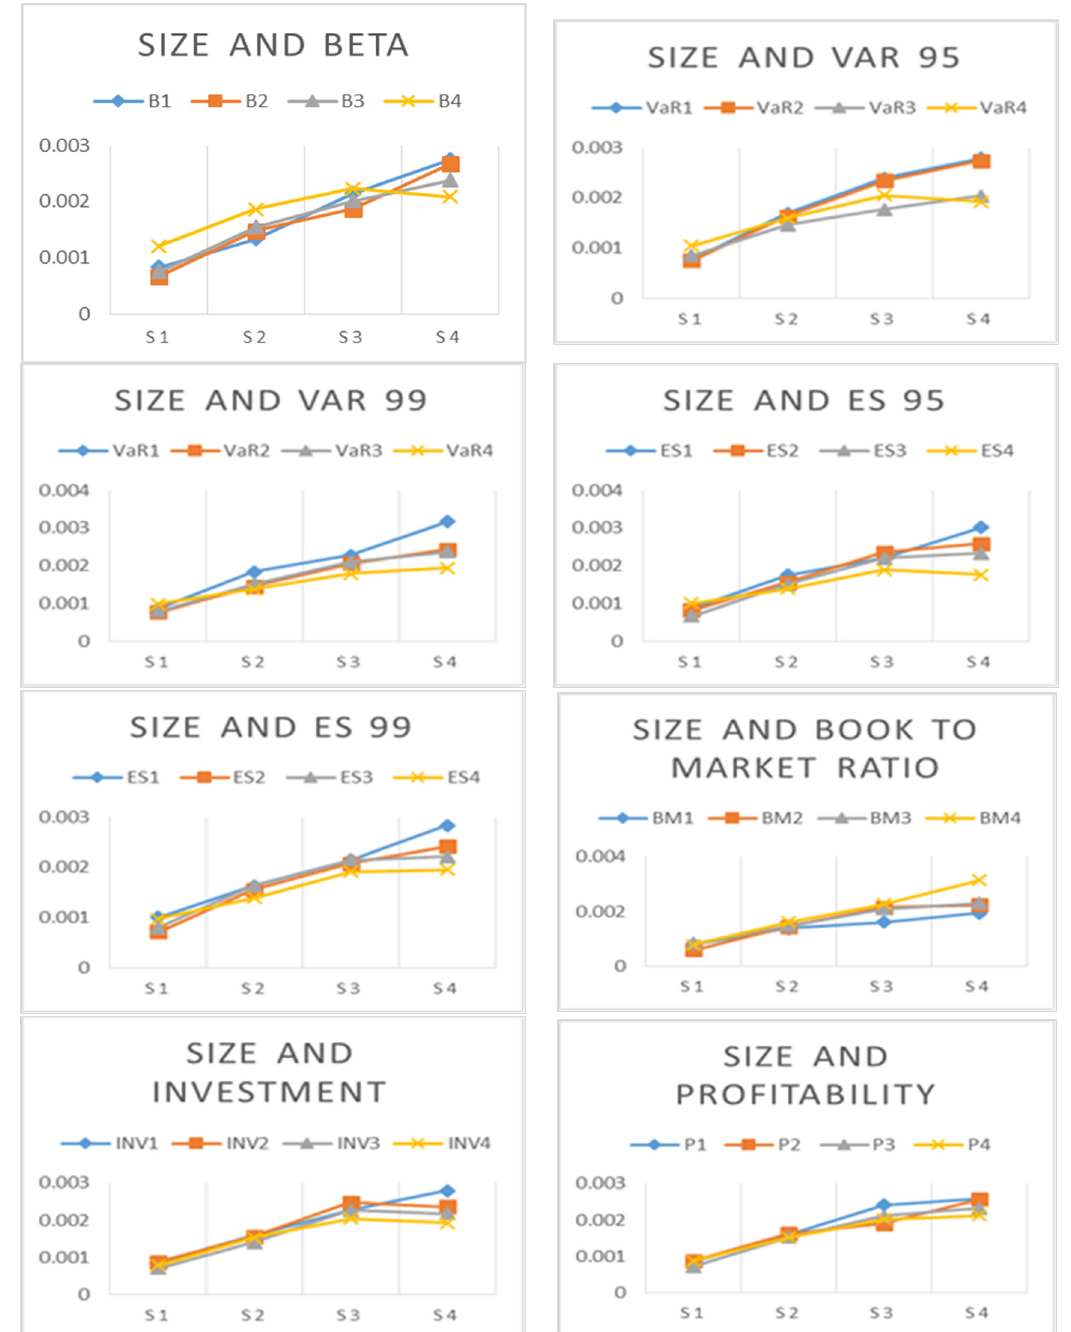
Figure A10. Portfolios’ Trend Lines.